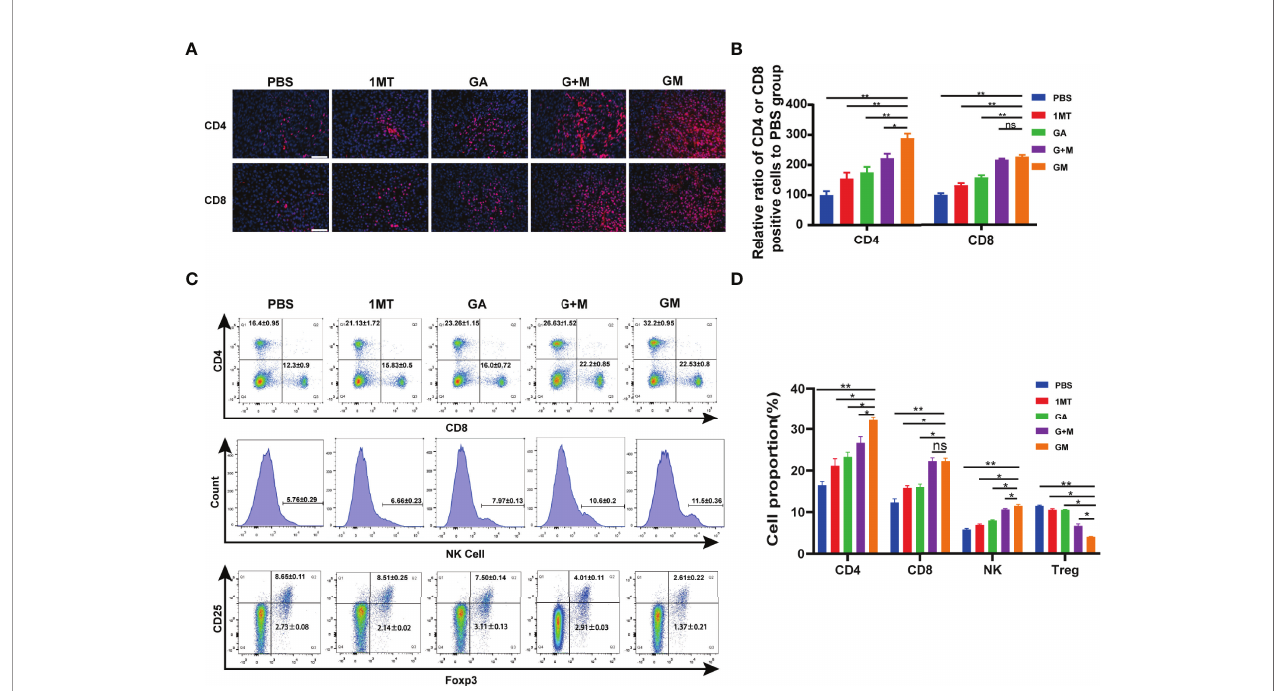
FIGURE 5 | GM-mediated immune response in the B16F10 cell tumor model. (A) Representative immuno fl uorescence images of the tumor showing CD4 + T cell and CD8 + T cell after the corresponding treatments and (B) the quantitative analysis (scale bar: 200 µm). (C) The ratios of CD4 + , CD8 + , NK1.1, and CD4 + Foxp3 + T cells in the spleen were detected by fl ow cytometry after the corresponding treatments and (D) the quantitative analysis. Data are presented as means ± SD, ns, no signi fi cance, *p < 0.05, **p <